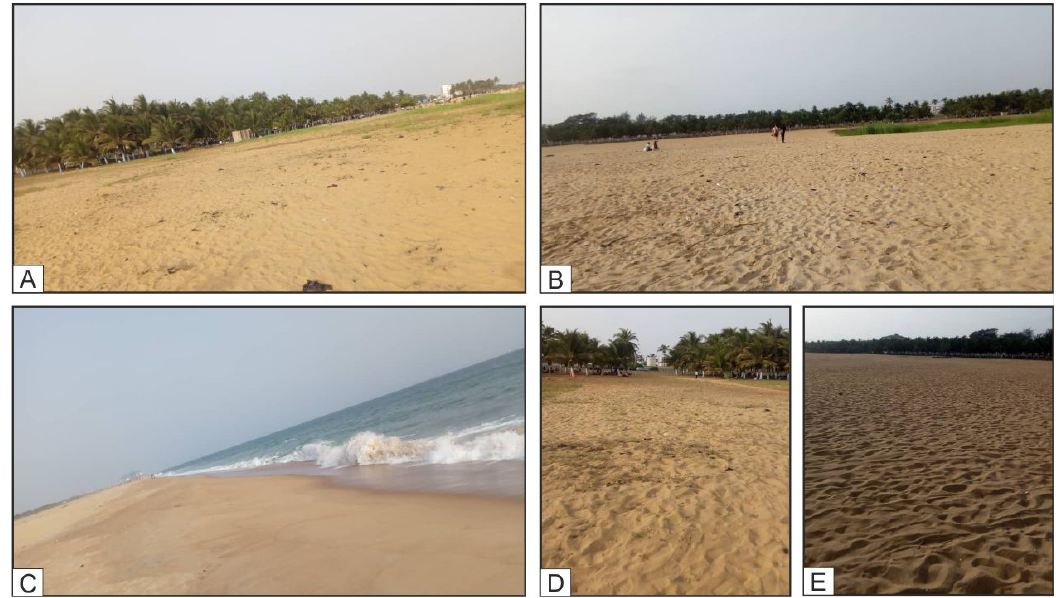
Figure 3. Geomorphological features ( A – E ) of the about 400 m wide expanding beach located to the west of the Lomé port. The beach is often bounded by vegetation including trees (Photographs December 2019–January 2020).